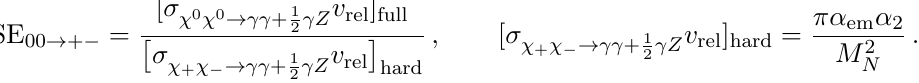
Figure 3 . Indirect detection bound from emission of photon lines of energy E D coupling ( (cid:20) = 1). Exclusion limits from FERMI are obtained by recasting the results in [43] to account for the di(cid:11)erent ratio of photon energy and DM mass. SE for the triplet has been extracted from